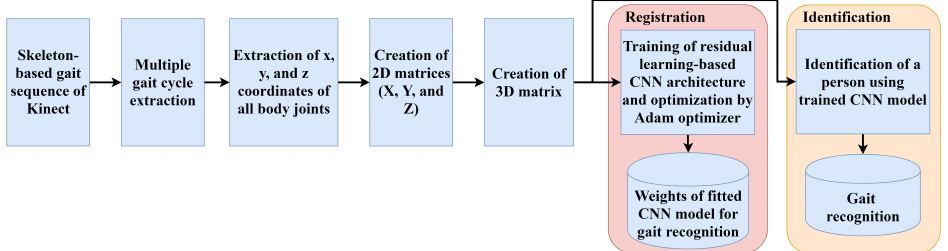
Figure 1. Overall system flowchart of the proposed framework.